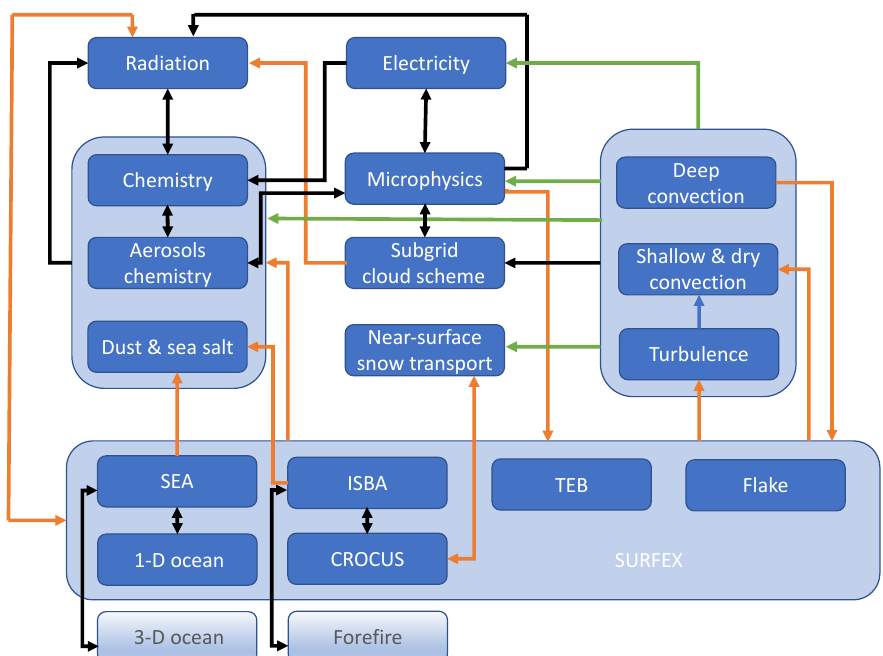
Figure 6. Physical and chemical schemes and the one-way or two-way links among them. Black arrows represent the direct interaction among schemes, orange arrows the indirect interaction through fluxes or cloud fraction, and green arrows the subgrid transport of prognostic